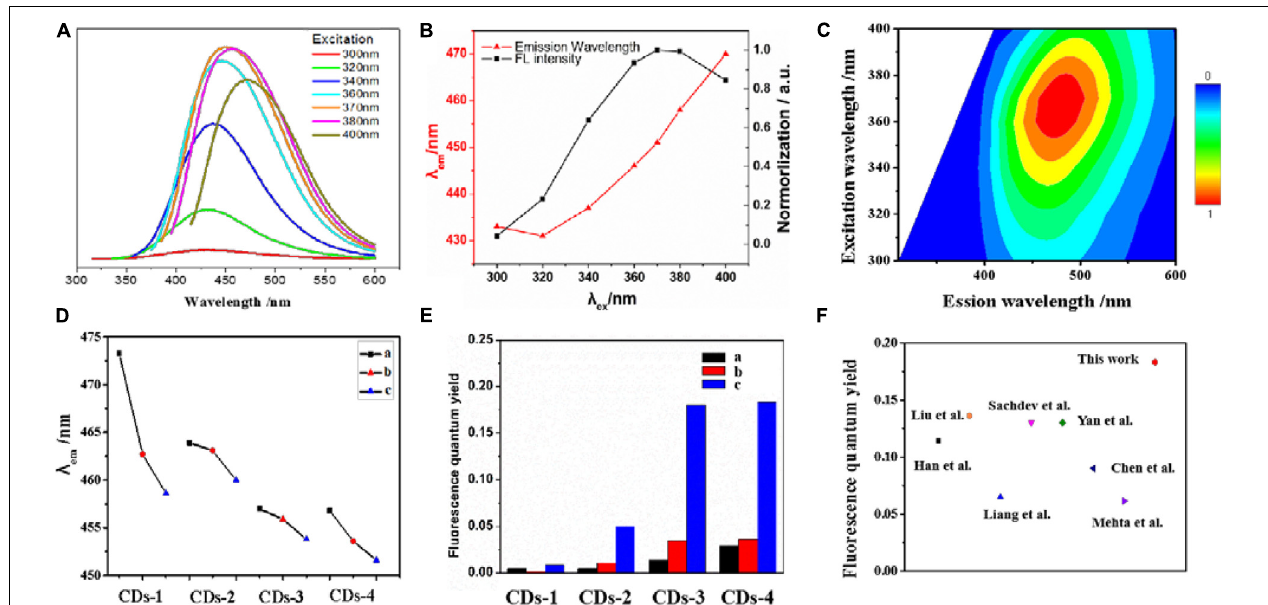
FIGURE 3 | The excitation-dependent PL behavior of the CDs-4a aqueous solution (A,B) . (C) 2D excitation-emission contour map of CDs-4a at different excitation wavelengths. The emission wavelength of different CDs samples with the same excitation wavelength at 370 nm (D) . The fluorescence quantum yield of different CDs samples (E) . Comparison of fluorescence quantum yield of CDs-4a with reported CDs in the literatures (F)